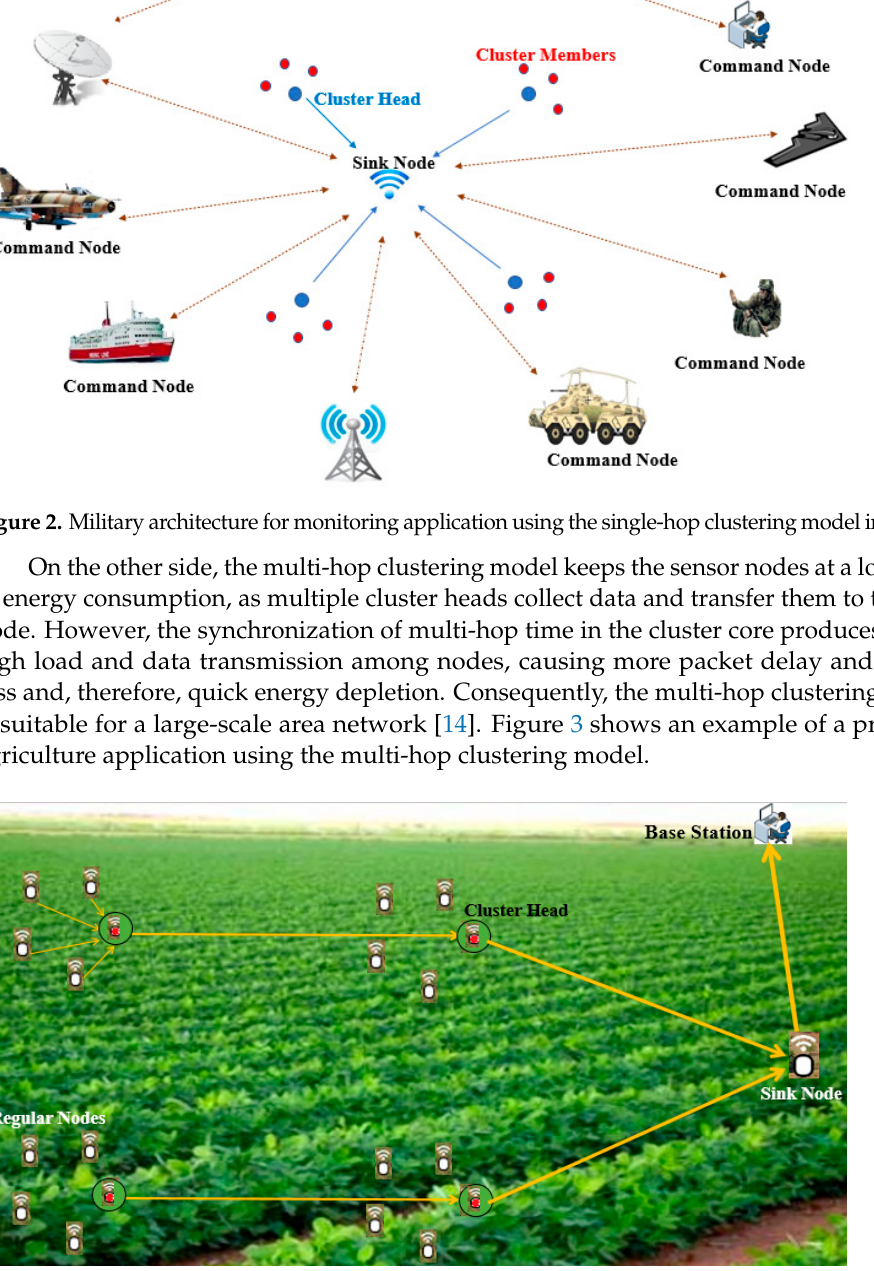
Figure 3. Precision agriculture architecture for monitoring application using the multi-hop cluster- ing model in WSNs.